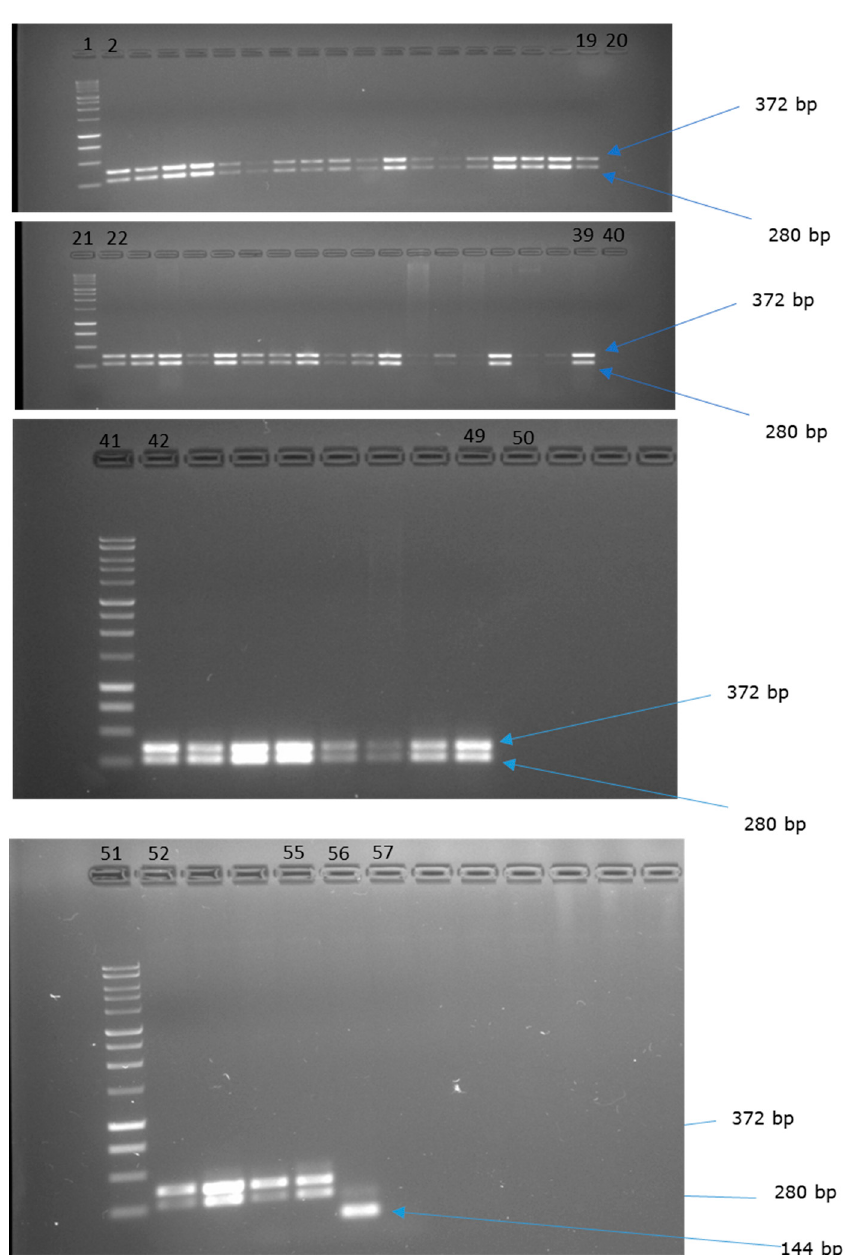
Figure 6. Detection and identification of Ralstonia solanacearum strains. Lanes 1, 21, 41 and 52: molecular marker (100 bp); Lanes 20, 40, 50 and 57: negative control; Lanes 2–19, 22–39, 42–49 and 52–55: isolates of this study; Lane 57: Phylotype 1 (PD 7123) positive